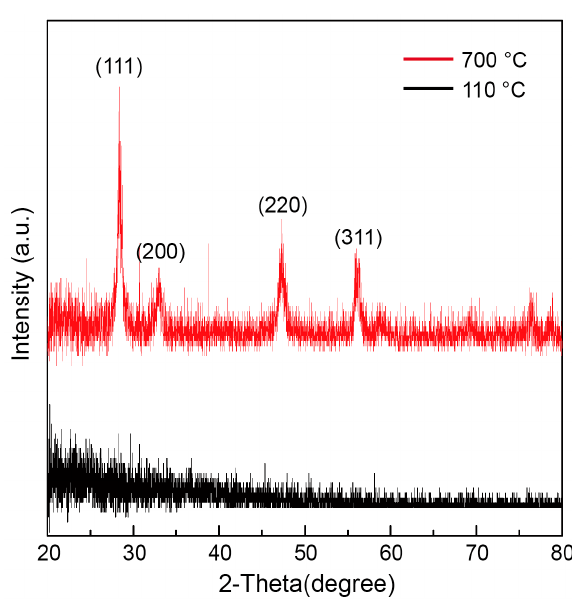
Figure 1. XRD patterns of SDC precursor solution on Si baked at 110 °C and fired at 700 °C.